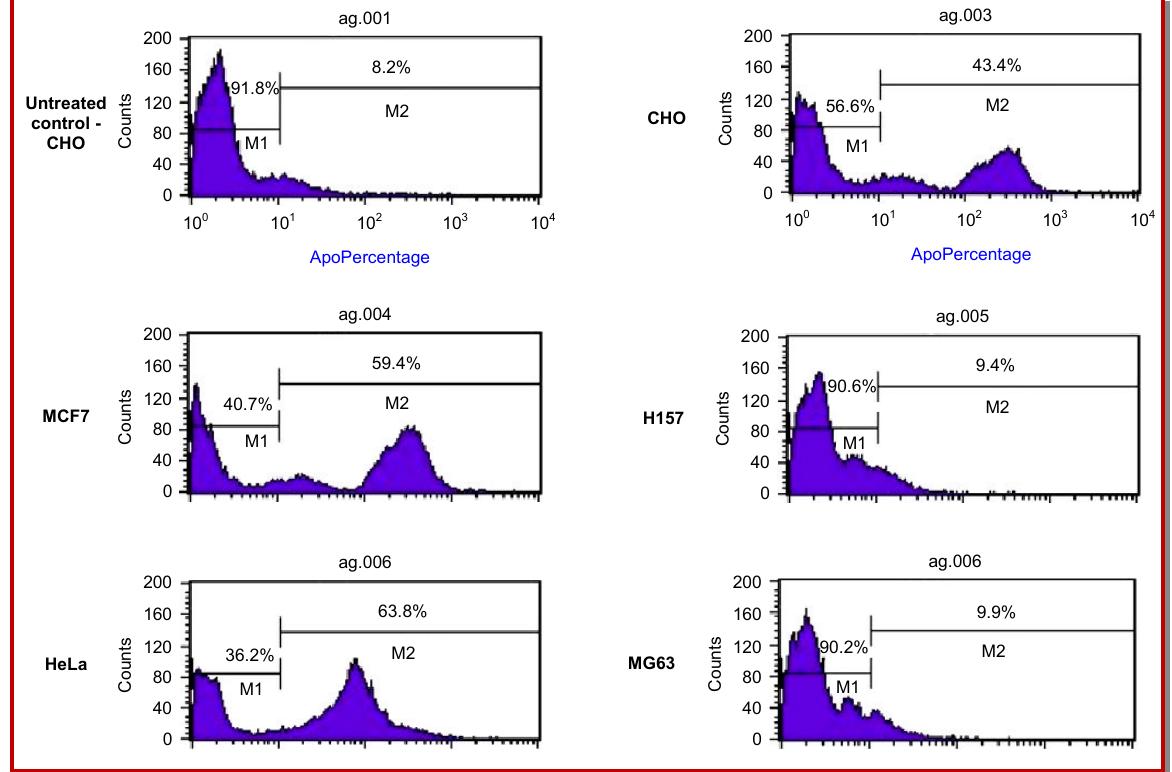
Figure 5: APOPercentage TM apoptosis assay on CHO, MCF7, H157, HeLa and MG63 cell lines treated for 1 hour with 0.5 mg/mL T. violacea crude aqueous extract. The M1 and M2 regions of the histograms represent the viable cell and apoptotic cell popula- tions,